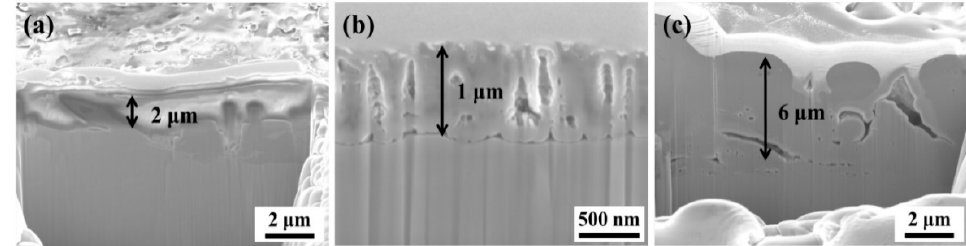
Figure 27. Surface-modified Ti pictures obtained using a focused ion beam (FIB) in ( a ) HA, ( b ) SLA/AO, and ( c ) SLA/MAO. Reprinted with permission from [84]. Copyright 2021 MDPI. Distributed under Creative Commons Attribution-based license (CCBY 4.0.).